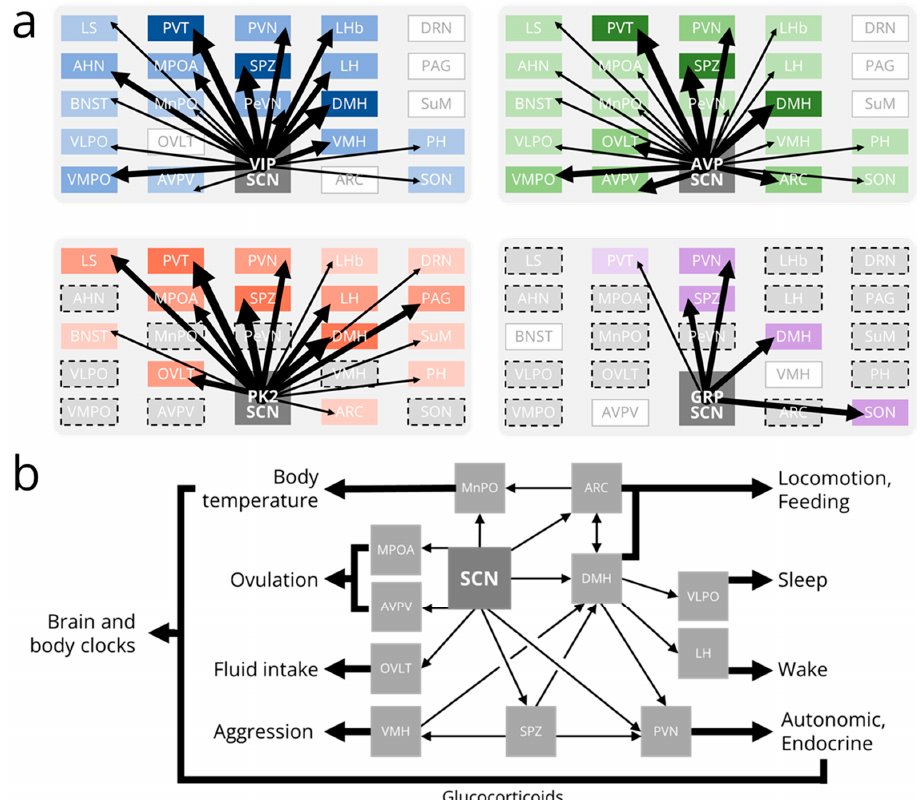
Figure 3. Outputs from the SCN. ( a ) Schematics depicting the relative strengths of synaptic outputs from vasoactive intestinal peptide (VIP, blue), arginine vasopressin (AVP, green), prokineticin 2 (PK2, red), and gastrin-releasing peptide (GRP, purple) producing suprachiasmatic nucleus (SCN) neurons. Boxes are roughly organized such that the brain region in the top left is the most rostral and most dorsal. Darker colors and thicker arrows represent stronger inputs onto a given brain region. Gray boxes with no dashed outlines indicate brain regions with no inputs from an SCN subpopulation. Gray boxes with dashed outlines indicate brain regions whose (absence of) inputs from an SCN subpopulation have not been experimentally determined. Note that the depicted GRP efferent projections have not been identified using modern genetic tools. ( b ) Schematic depicting output pathways from the SCN to several rhythmic behaviors and physiological processes. Glucocorticoid release and body temperature rhythms allow the SCN to synchronize distant brain and body clocks. AHN, anterior hypothalamic nucleus; ARC, arcuate nucleus; AVPV, anteroventral periventricular nucleus; BNST, bed nucleus of the stria terminalis; DMH, dorsomedial hypothalamus; DRN, dorsal raphe nucleus; LH, lateral hypothalamus; LHb, lateral habenula; LS, lateral septum; MPOA, medial preoptic area; MnPO, median preoptic area; OVLT, organum vasculosum of the lamina terminalis; PAG, periaqueductal gray; PH, posterior hypothalamus; PVN, paraventricular nucleus of the hypothalamus; PVT, paraventricular nucleus of the thalamus; PeVN, periventricular nucleus; SON, supraoptic nucleus; SPZ, subparaventricular zone; SuM, supramammillary nucleus; VLPO, ventrolateral preoptic nucleus; VMH, ventromedial hypothalamus; VMPO; ventromedial preoptic